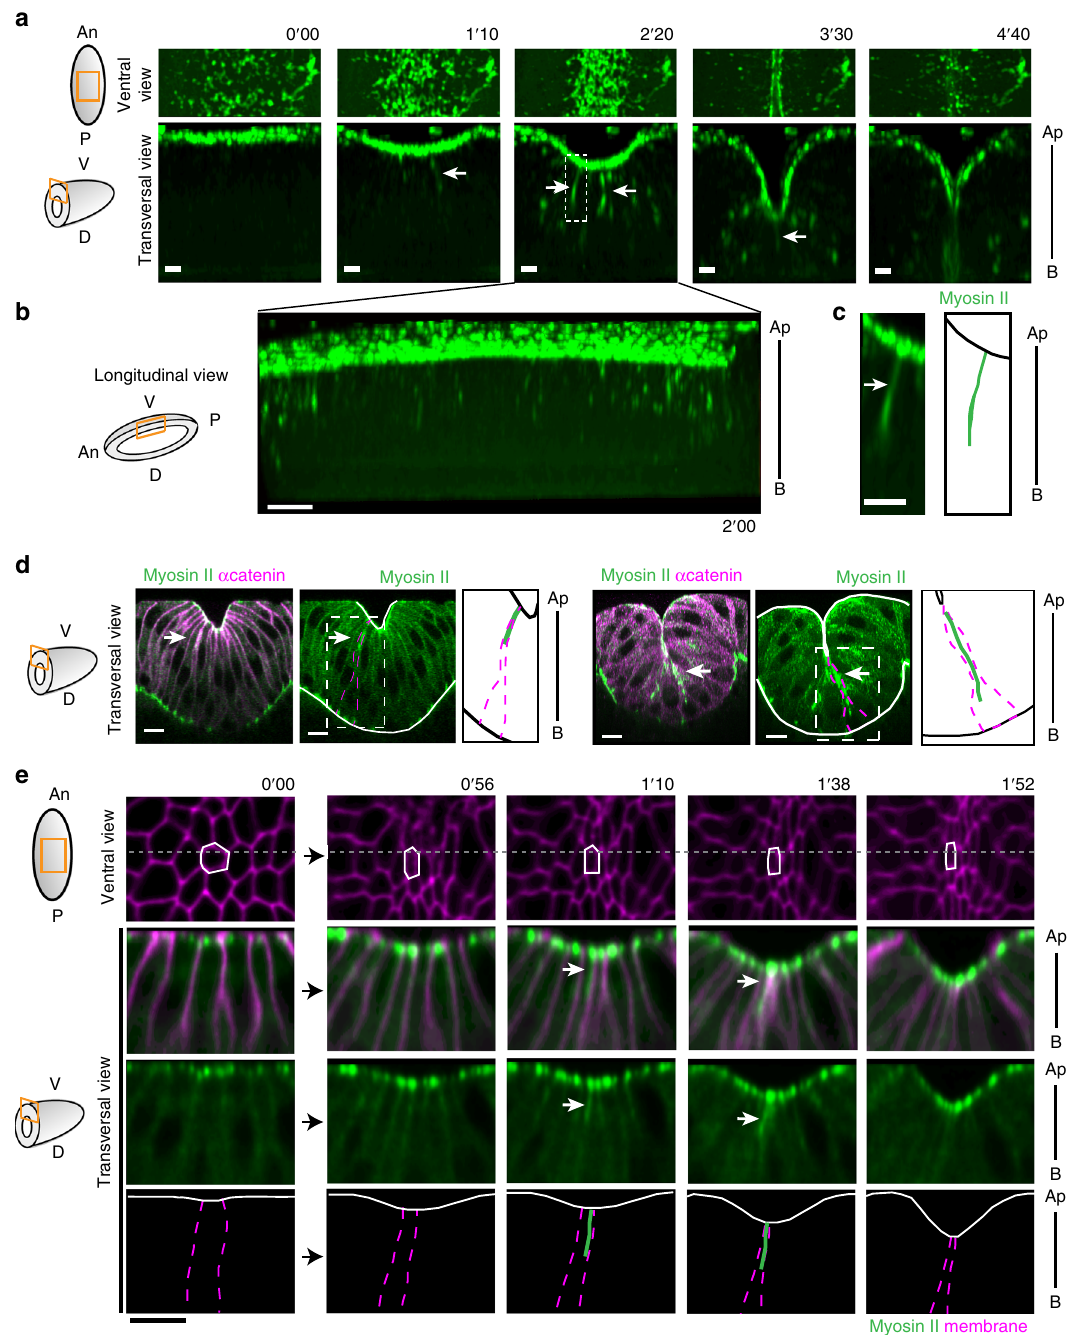
Fig. 4 Cells from the mesoderm form myosin II apico-basal cables during mesoderm invagination. a – c Time-lapse images of the ventral part of a sqhKI [eGFP] embryo during invagination (ventral and transversal views, see schemes, a ). First, myosin II is accumulated apically (ventral view). Then, transient linear structures perpendicular to the apical surface are formed (white arrows, transversal view), from the onset to the end of invagination ( n = 82). See Supplementary Movie 4. Scale bar: 10 µ m. b Longitudinal view of the same tissue at t = 2 min showing these apico-basal structure of myosin II all along the embryo. Scale bar: 10 µ m. c Enlargement of the apico-basal myosin II transient structure (white arrow) in the dashed white framed in ( a ) and the corresponding scheme. See Supplementary Movie 5. Scale bar: 5 µ m. d Transversal views of the invaginating mesoderm in fi xed embryos showing a myosin II cable formed in cells that have just constricted their apex, at early (left) and late (right) stages of invagination (white arrows). The apical and basal surfaces are outlined in white. Right of each panel: Schemes of the framed regions focusing on the apically constricted cell producing the apico-basal structure of myosin II (green line: myosin II cable, magenta dashed line: cell outline, black line: outline of the epithelium). Scale bar: 10 µ m. e Time-lapse images of mesoderm invagination in a sqhKI[eGFP]; PH-mCherry embryo (ventral and transversal views, see schemes) showing the dynamics of a myosin II cable (white arrow) formed in a cell that constricts its apex (outlined by a white line in the ventral views). Dashed lines indicate the section corresponding to transversal views. Schemes recapitulate myosin II dynamics (bottom panel). See Supplementary Movie 6. Scale bar: 10 µ m. An anterior, P posterior, V ventral, D dorsal, Ap apical, B basal